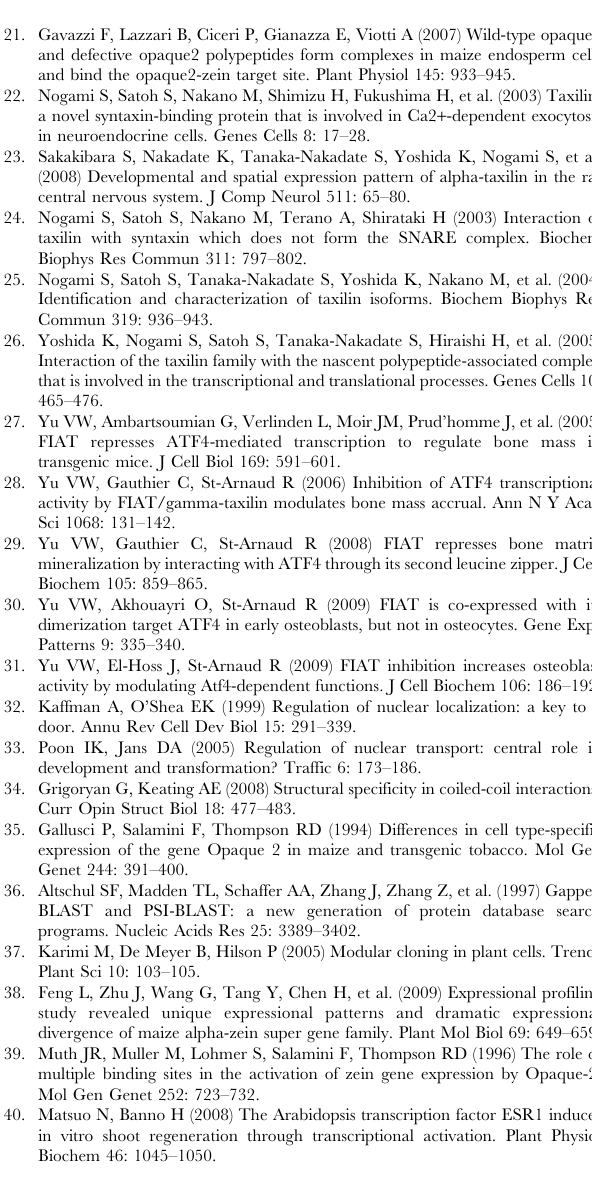
Figure S1 Alignment of ZmTaxilin protein with other Taxilin homologous proteins. Yellow, green and blue background means the sequence was identical, weakly similar and conservative respectively. There is an obvious coiled-coil domain at 200–450 aa. In the coiled-coil domain there are three conserved zipper domain which have a conserved leucine acid every seven amino acid. Figure S2 Localization of YFP-O2 in onion epidermal cells. Onion epidermal cells were bombarded with YFP-O2. Red represents YFP fluorescence. Differential interference contrast (DIC) was used in light mode.